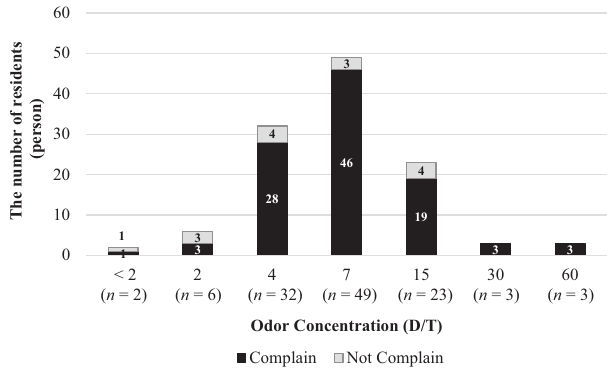
Figure 1. Complaint amounts at each concentration ( n 5